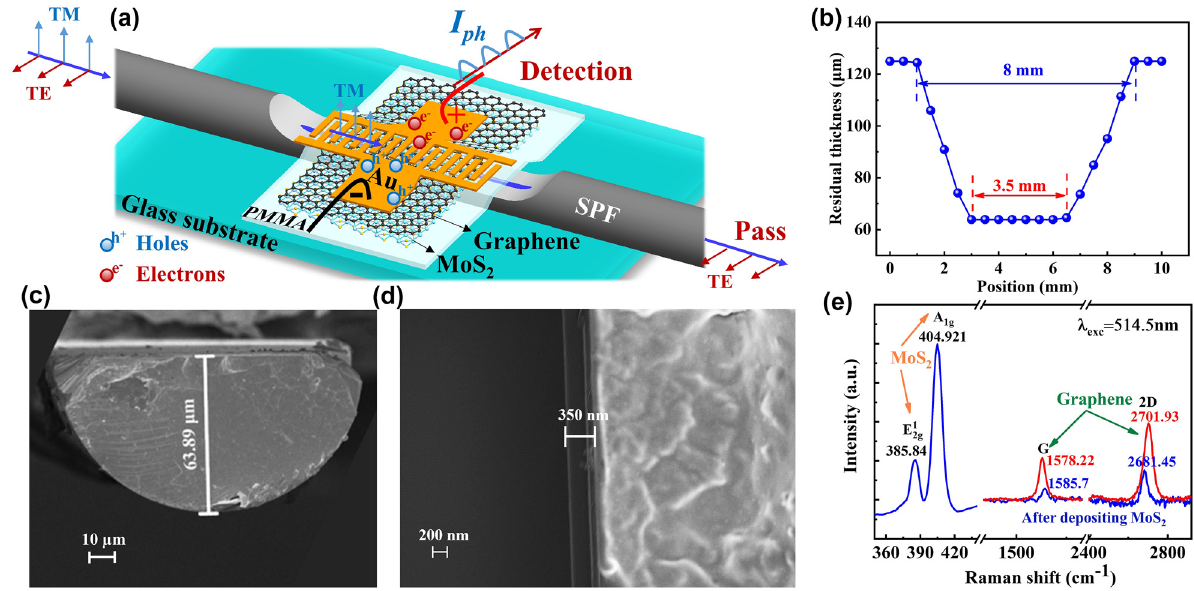
Figure 1: Schematic and characterization. (a) Schematicstructureof PPID;(b) morphological characteristic of theSPF along the fi ber; (c) SEM imageof thecross section of PPID; (d) SEM imageattheinterfacebetweenthegraphene/MoS 2 /PMMA fi lmandglasssubstrate;(e)Ramanspectraofthepristinegraphene(redcurve)and the graphene/MoS 2 heterostructures (blue